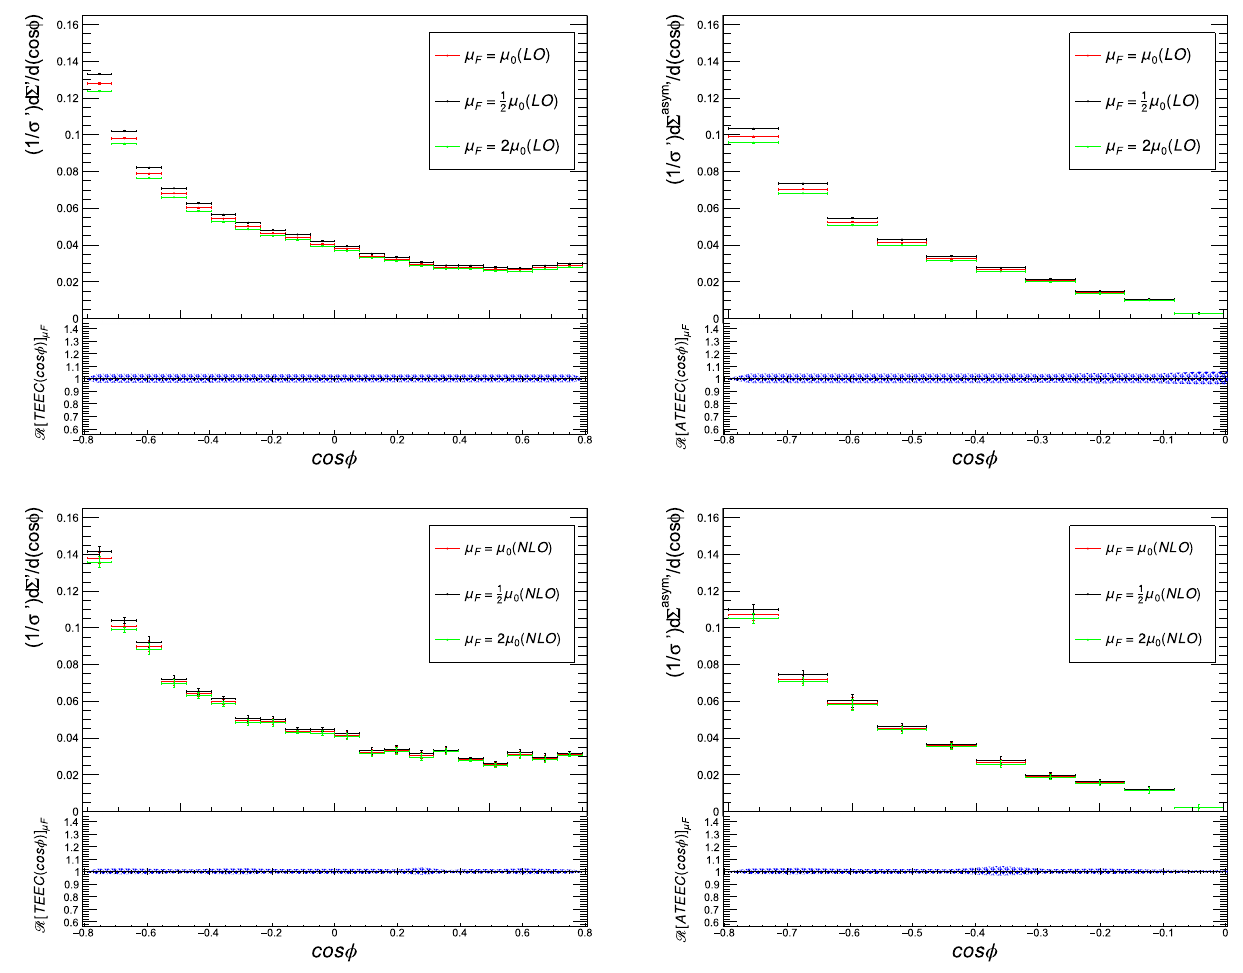
Fig. 5 Fatorization scale dependence of the differential distribution 1 /σ (cid:7) d (cid:9) (cid:7) / d ( cos φ) and its asymmetry 1 /σ (cid:7) d (cid:9) (cid:7) asym / d ( cos φ) in the leading order (upper frames) and the next to leading order (lower frames) as in Fig. 4, but for the high- Q 2 range 150GeV 2 < Q 2 < 1000GeV 2 at